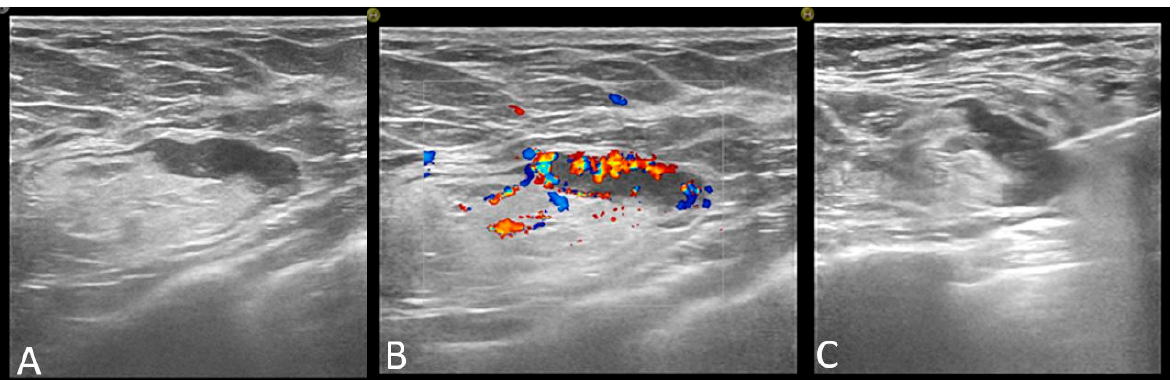
Figure 4. Axillary lymph node classified as abnormal on ultrasound: focal cortical thickening of more than 3 mm ( A ) with chaotic vessels ( B ), and core ‐ needle biopsy was performed ( C ).